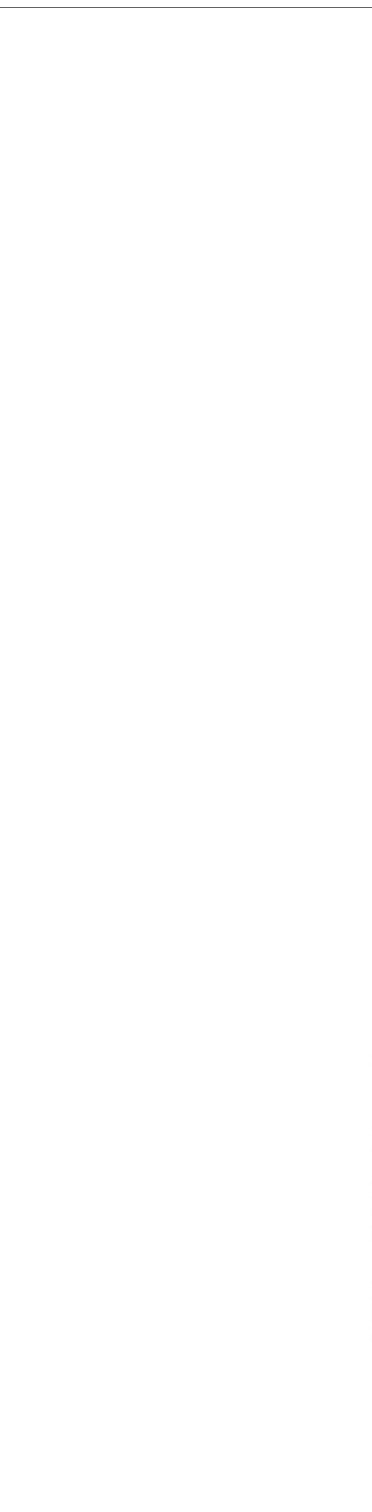
FIGURE 4 | Functional interaction of glucose and insulin on serum SPX level and SPX transcript expression in glandular stomach of the mice. IP injection with glucose alone (2 g/kg BW), insulin alone (3 IU/kg BW), or in combination of both was performed in the mice (with saline injection as control treatment) and blood samples and glandular stomach were harvested at 1 h after drug treatment. Serum levels of glucose and SPX (A) as well as SPX mRNA expression in glandular stomach (B) were monitored using the respective ELISA and real-time PCR assays. Data presented (mean ± SEM, N = 10) were analyzed with one-way ANOVA followed by Newman-Keuls test and the groups denoted by different letters represent a signi fi cant difference at p <